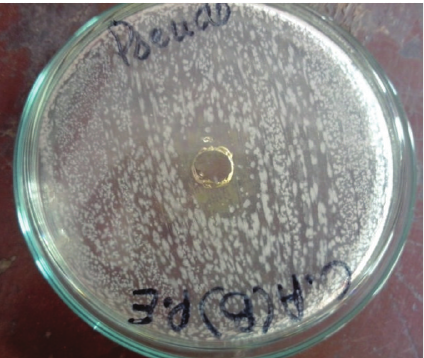
Figure 24: Zone of inhibition of petroleum ether extract of bark of C. ambrosioides L. against P. aeruginosa .